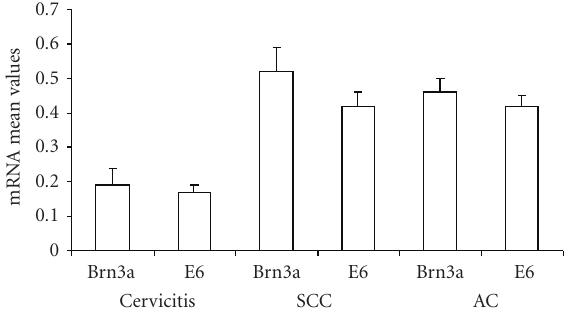
Figure 2: The mean and standard deviation of Brn-3a and E6 mRNA levels in cervical scrapes obtained from women with High-grade Cervical Intraepithelial Neoplasia (HG CIN) (squamous cell carcinoma (SCC) precancer) and High-grade Cervical Glandular Intraepithelial Neoplasia (HG CGIN) (adenocarcinoma (AC) precancer) and cervicitis (as a control group). Note the top bar designates the standard